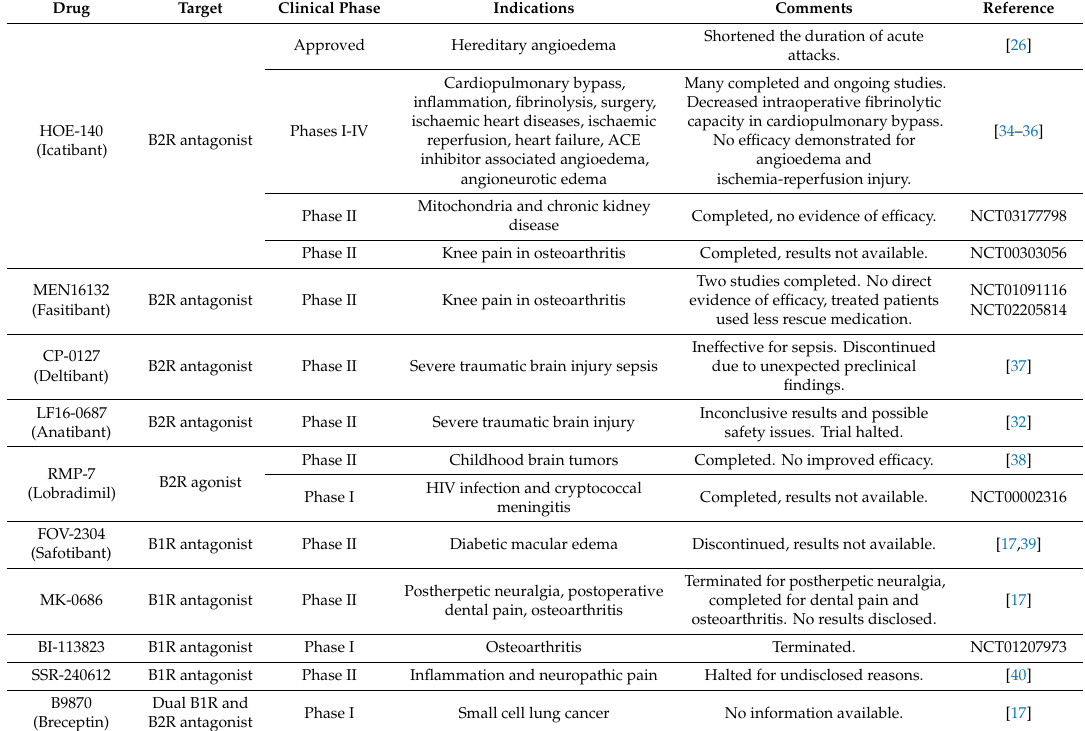
Table 1. B1R and B2R targeting therapeutics in clinical trials. Adapted from da Costa, P.L.N., et al. [17]. Drug